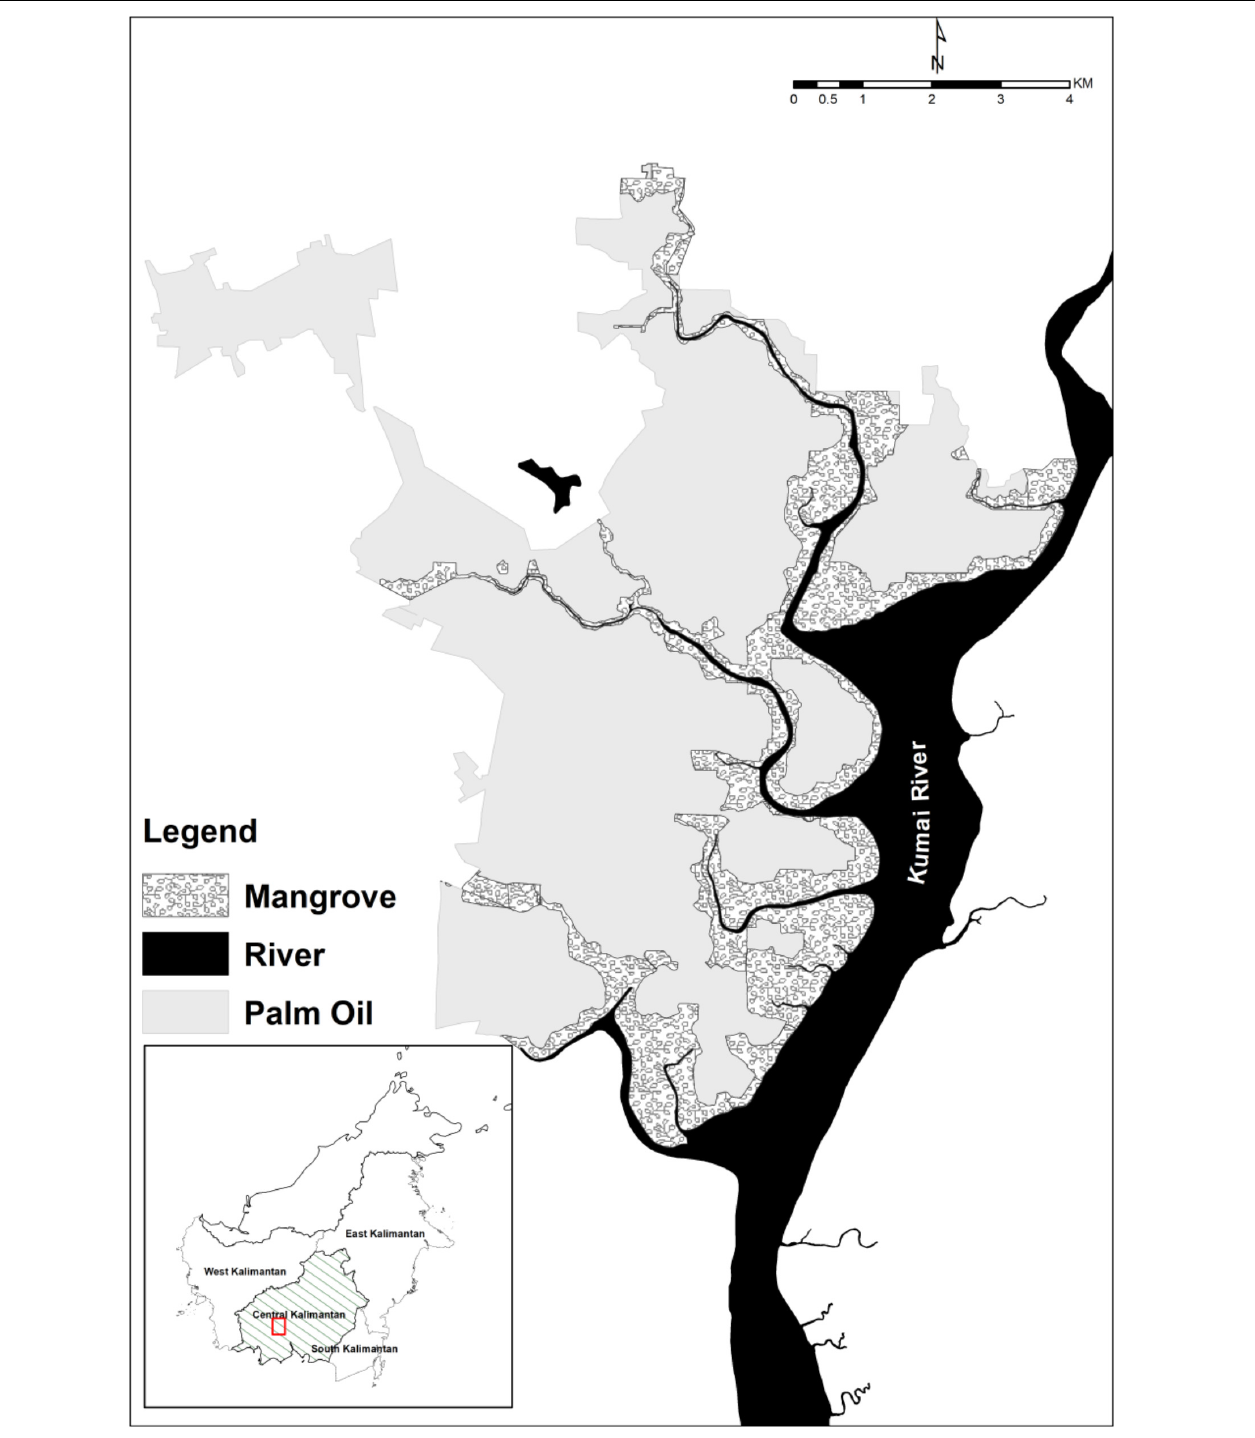
FIGURE 1 | The study area in “Lada Estate,” Central Kalimantan, Borneo.